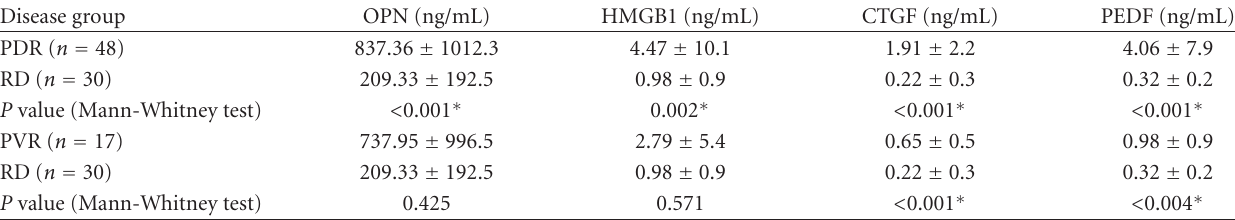
Table 1: Comparisons of mean angiogenesis and fibrogenesis regulatory factor levels in proliferative diabetic retinopathy (PDR), prolifera- tive vitreoretinopathy (PVR), and rhegmatogenous retinal detachment (RD) patients. Disease group